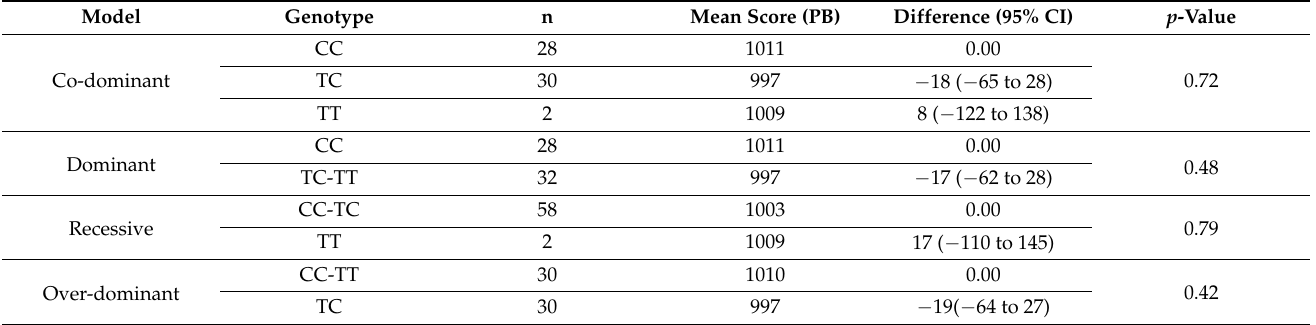
Table 2. Association analysis of the VDR rs2228570 polymorphism with competitive